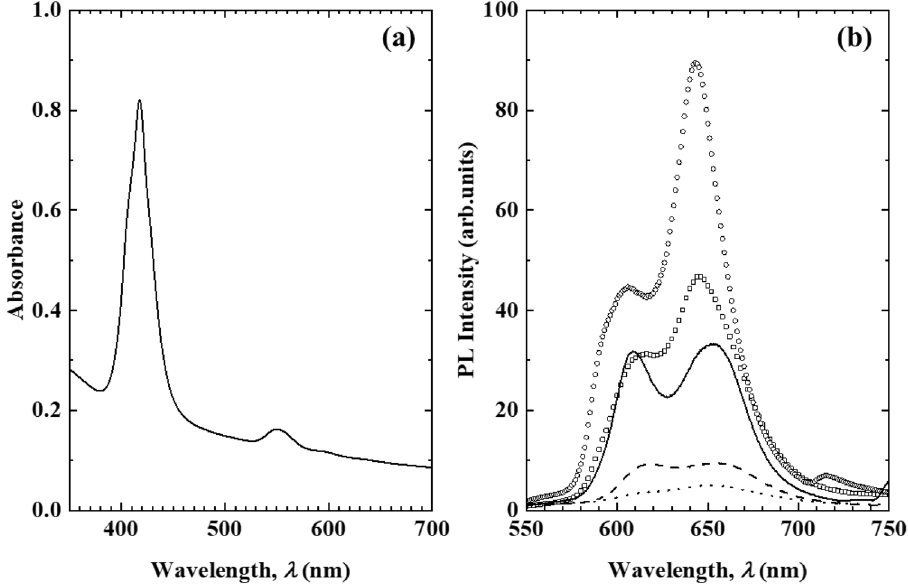
Figure 2. (a) Absorption spectrum of the transparent ZnTPPS/C10S/LDH film. (b) PL spectra of the transparent ZnTPPS/C10S/LDH film at excitation wavelengths of 410 (open square), 420 (open circle), 430 (solid line), 440 (broken line), and 450 (dotted line) nm.